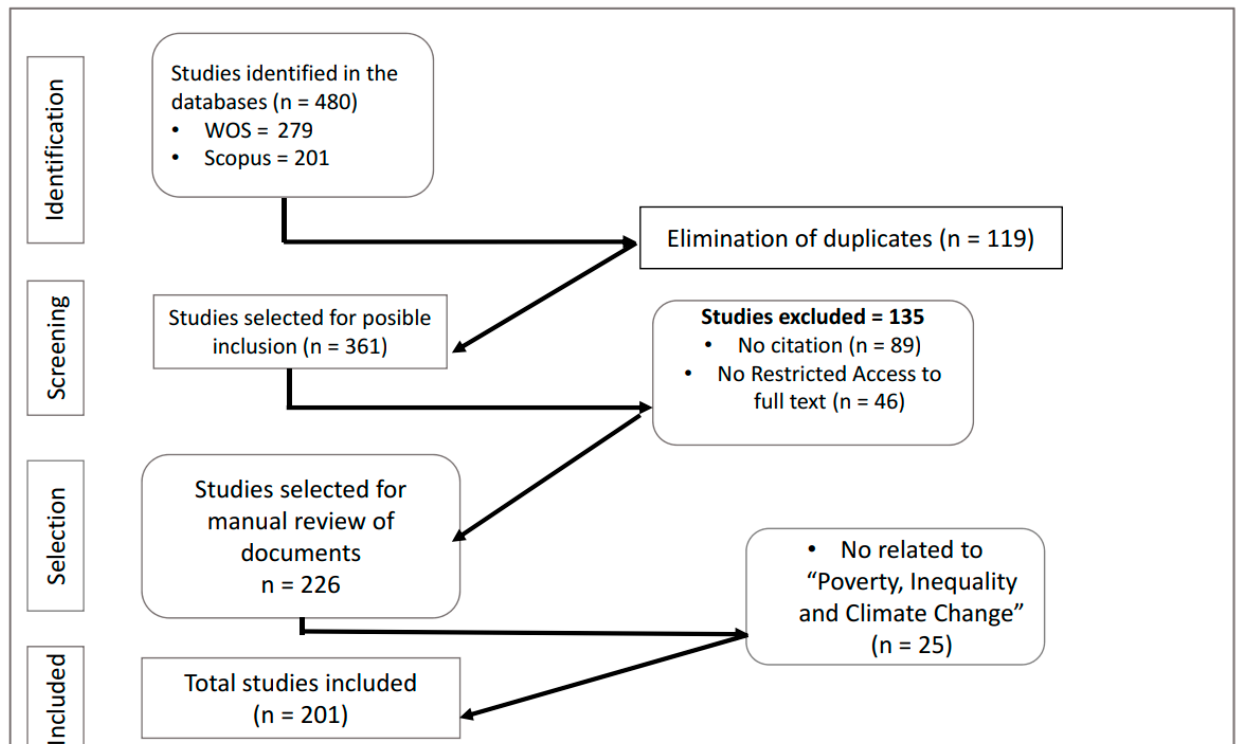
Figure 1. Flowchart of study selection process based on the PRISMA statement.